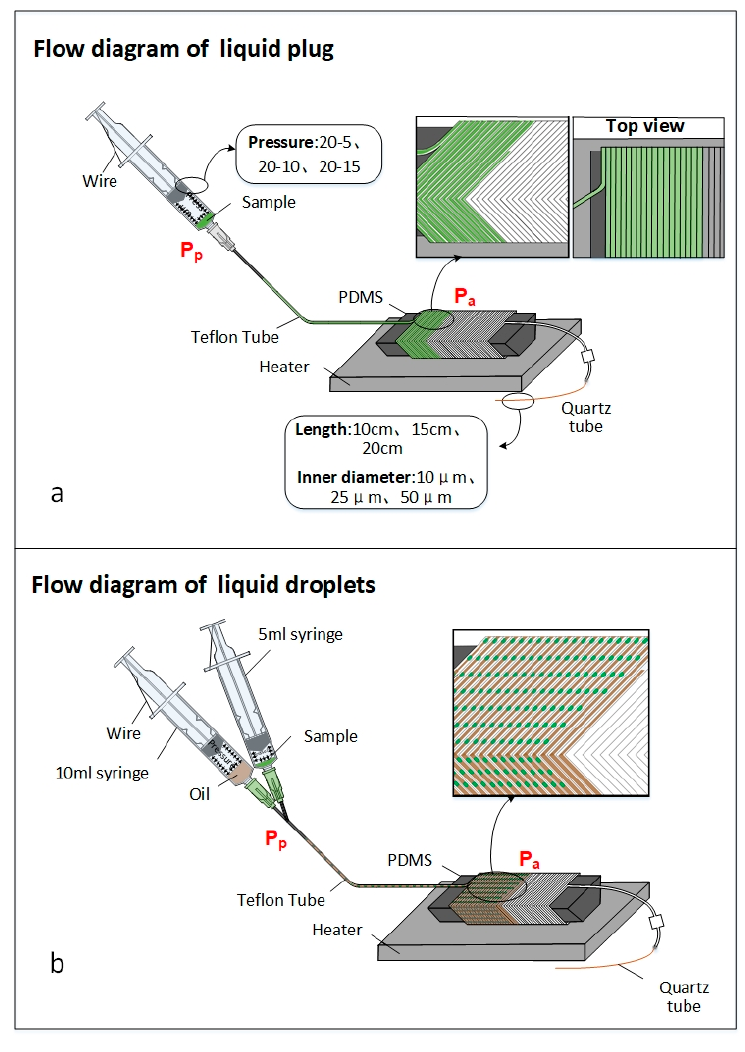
Figure 1. The principle of self-activated micropump applied to the end-opened system, where P p and P a represent the air pressures in the posterior and anterior ends of the reagent. ( a ) The self-activated plug flow and ( b ) the self-activated droplet flow.